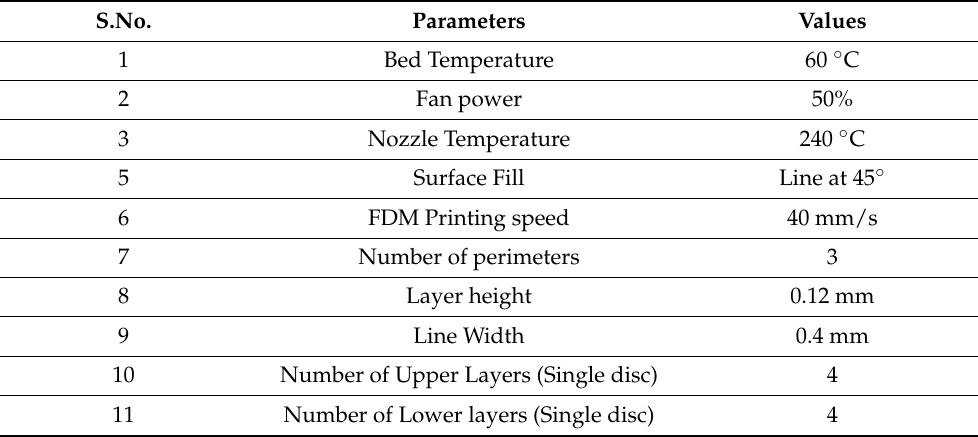
Table 4. Disc thickness for different numbers of discs and number of upper and lower layers.